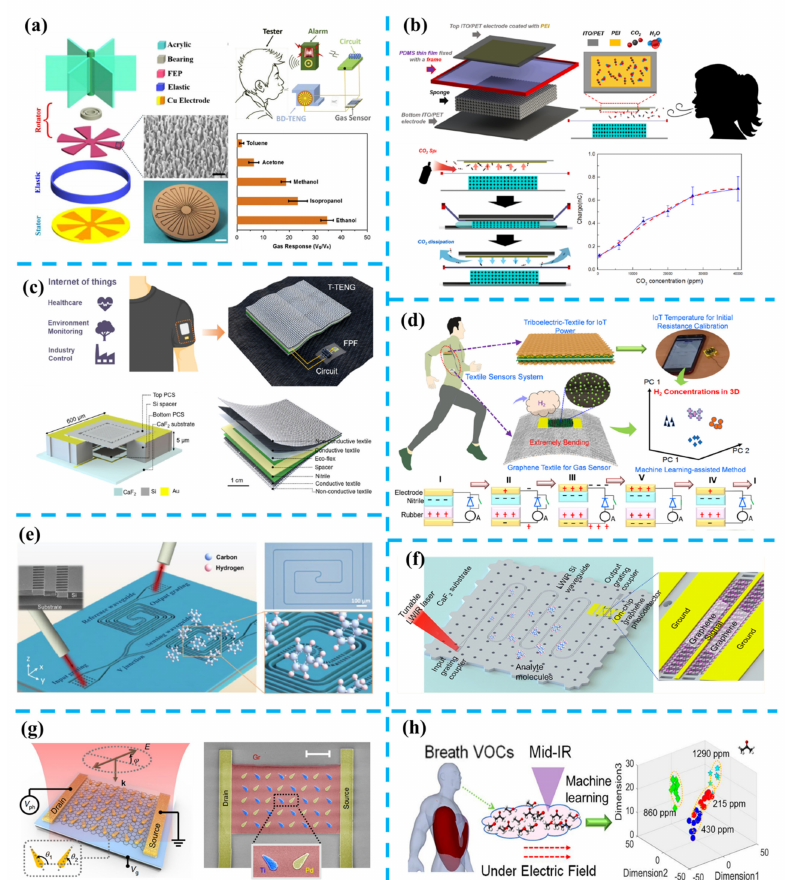
Figure 5. Gas sensing for smart home applications. ( a ) Blow-driven alcohol breath